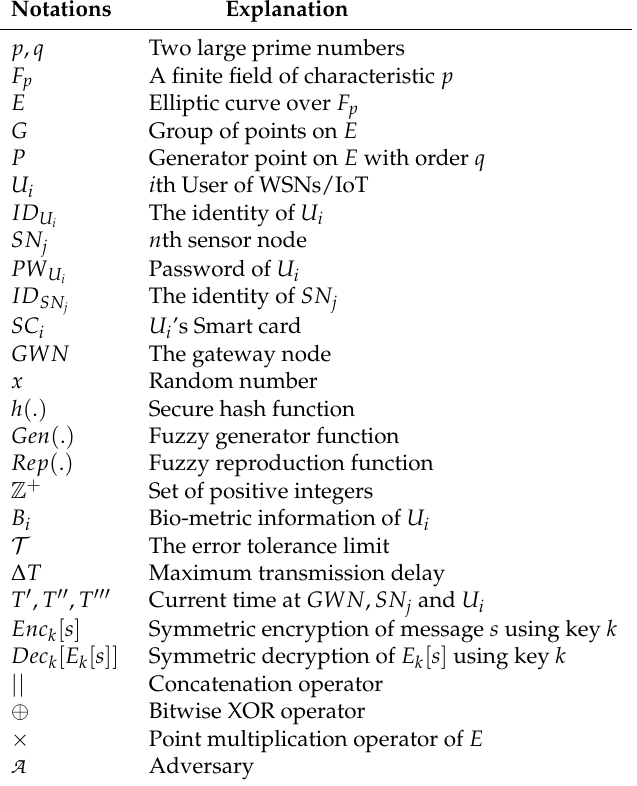
Table 1. Notations